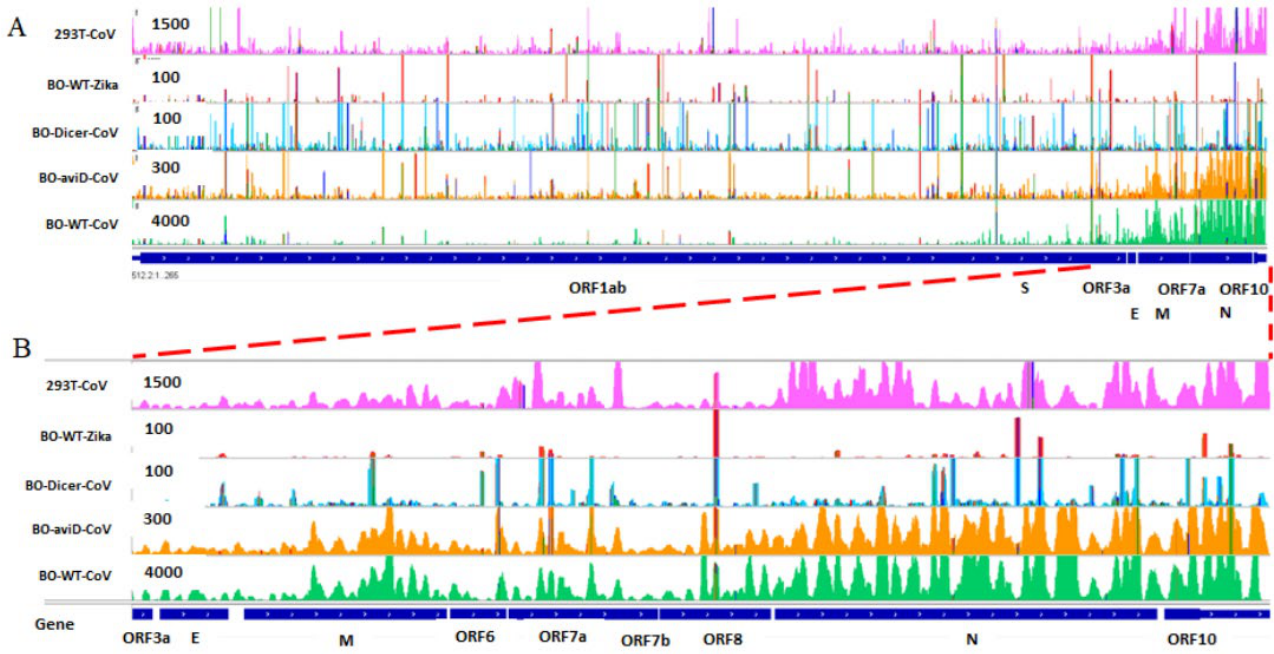
Figure 4. Comparative IGV view of reads from smRNAseq of HEK293T-hACE2 and mouse brain organoids mapped to the SARS-CoV-2 genome ( A ) Read coverage on full-length SARS-CoV-2 genome. ( B ) Read coverage at the E to ORF10 region. Refer to Table 1 for detailed information on infection and abbreviations of samples.